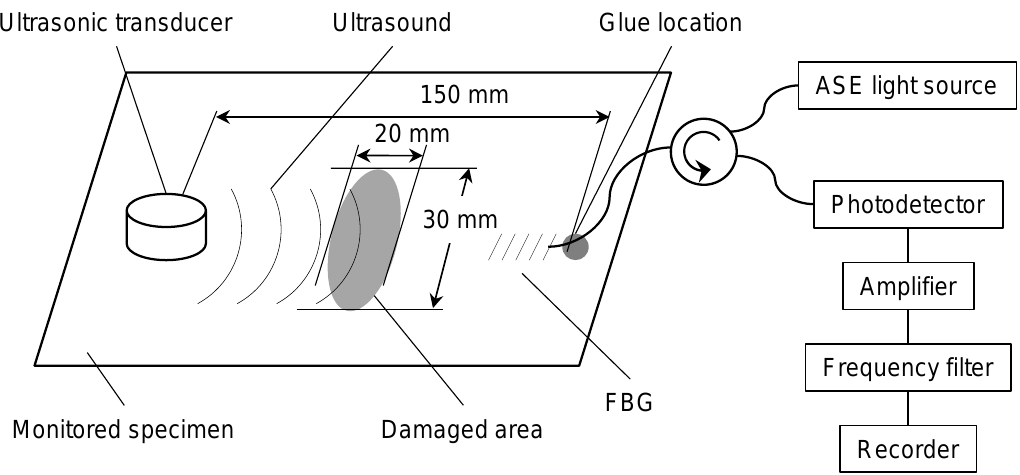
Figure 8. Experimental setup for ultrasonic damage